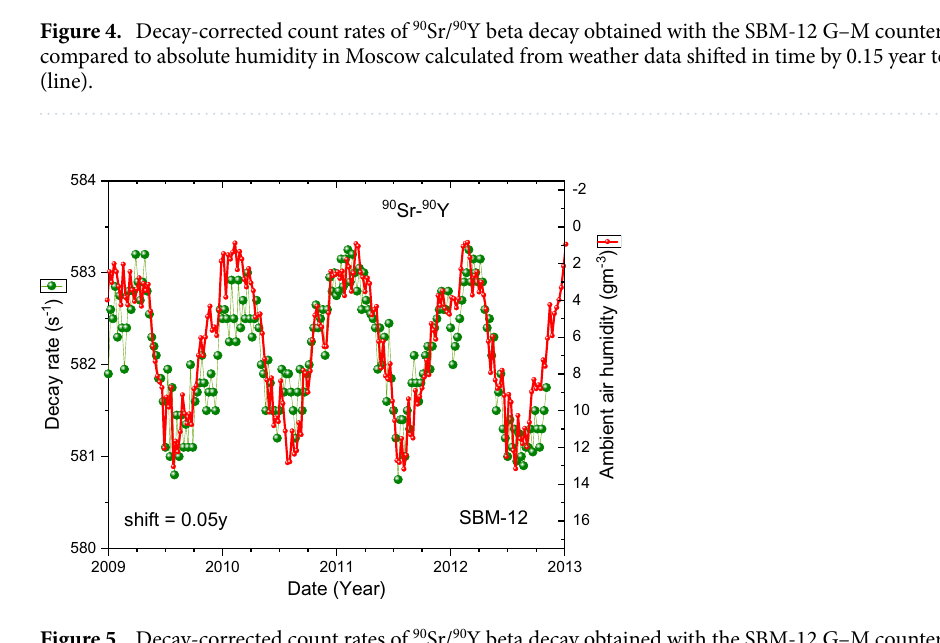
Figure 5. Decay-corrected count rates of 90 Sr/ 90 Y beta decay obtained with the SBM-12 G–M counter (dots) from 2009 to 2013, compared to absolute humidity in Moscow calculated from weather data shifted in time by 0.05 year to the right (line).